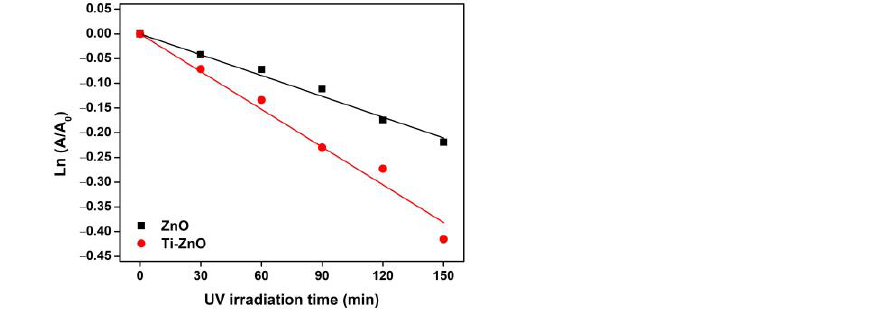
Figure 11. Plots of ln (A/A 0 ) versus UV irradiation time for analysis of degradation rate constant.